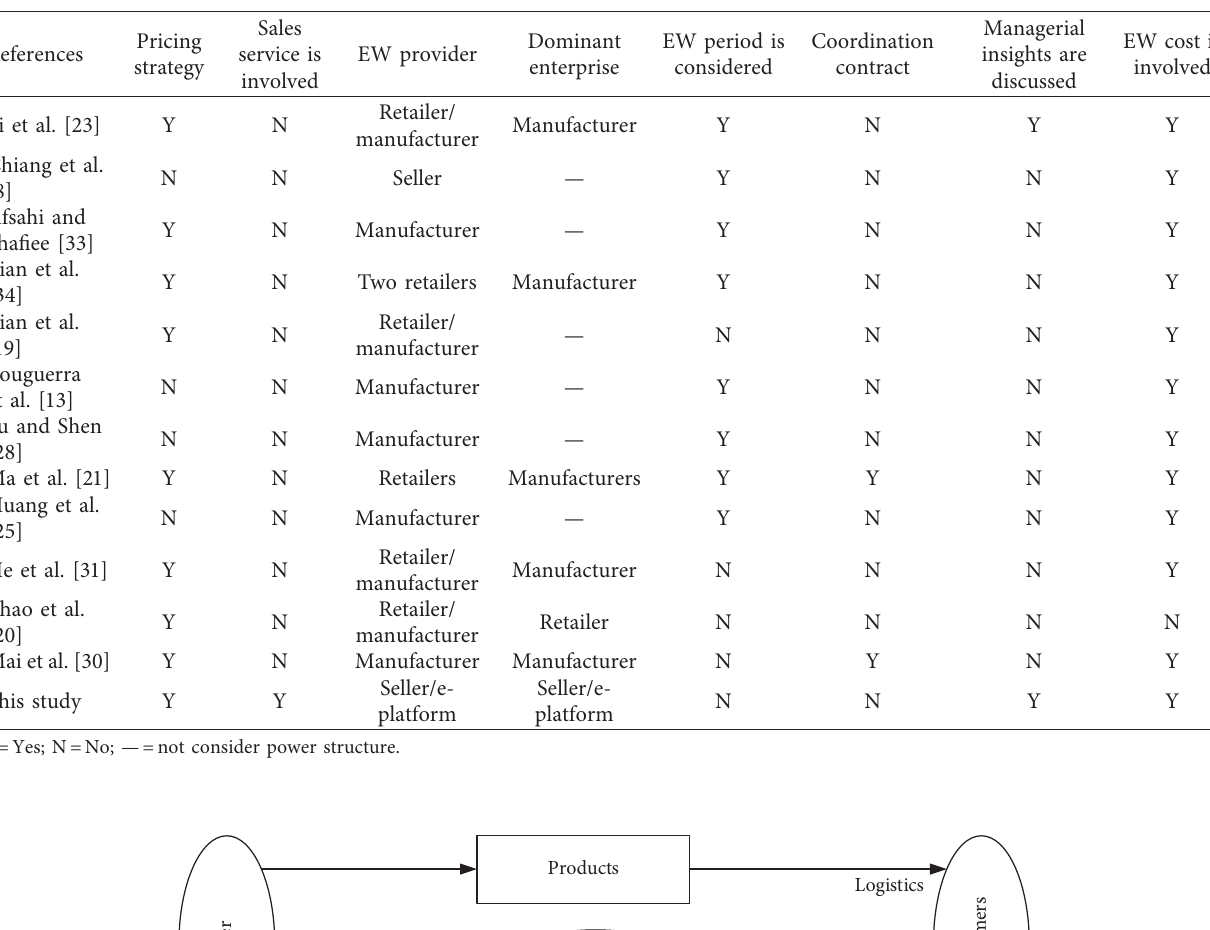
Table 1: Literature comparison of this study and the existing studies.